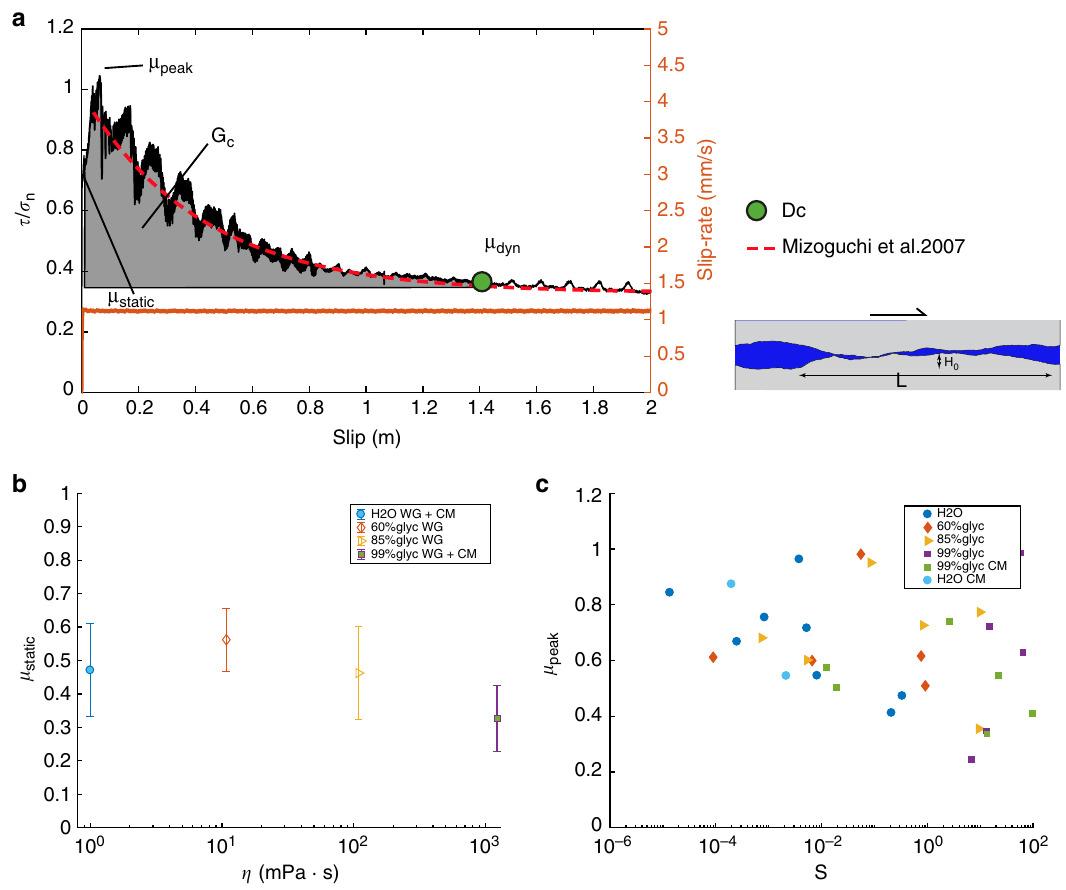
Fig. 1 Apparent friction coef fi cient vs. slip, friction coef fi cients vs. viscosity, and Sommerfeld number. Experiments were performed at an acceleration of 6.5 m s − 2 and effective normal stress σ eff up to 20 MPa, under the following environmental and hydraulic conditions: 100% water (H 2 O, blue in colour dots), 60% glycerol/40% water (orange diamonds), 85% glycerol/15% water (yellow triangles), and pure glycerol (99% glycerol, purple squares). a Apparent friction coef fi cient vs. slip for experiment S1315 performed at σ eff = 10 MPa in the presence of mixture 60% glycerol/40% water. μ static , μ peak , μ G D fi cient is fi tted following the exponential decay function proposed by Mizoguchi et al. 26 : dyn , c , and c are represented. The apparent friction coef μ ¼ μ